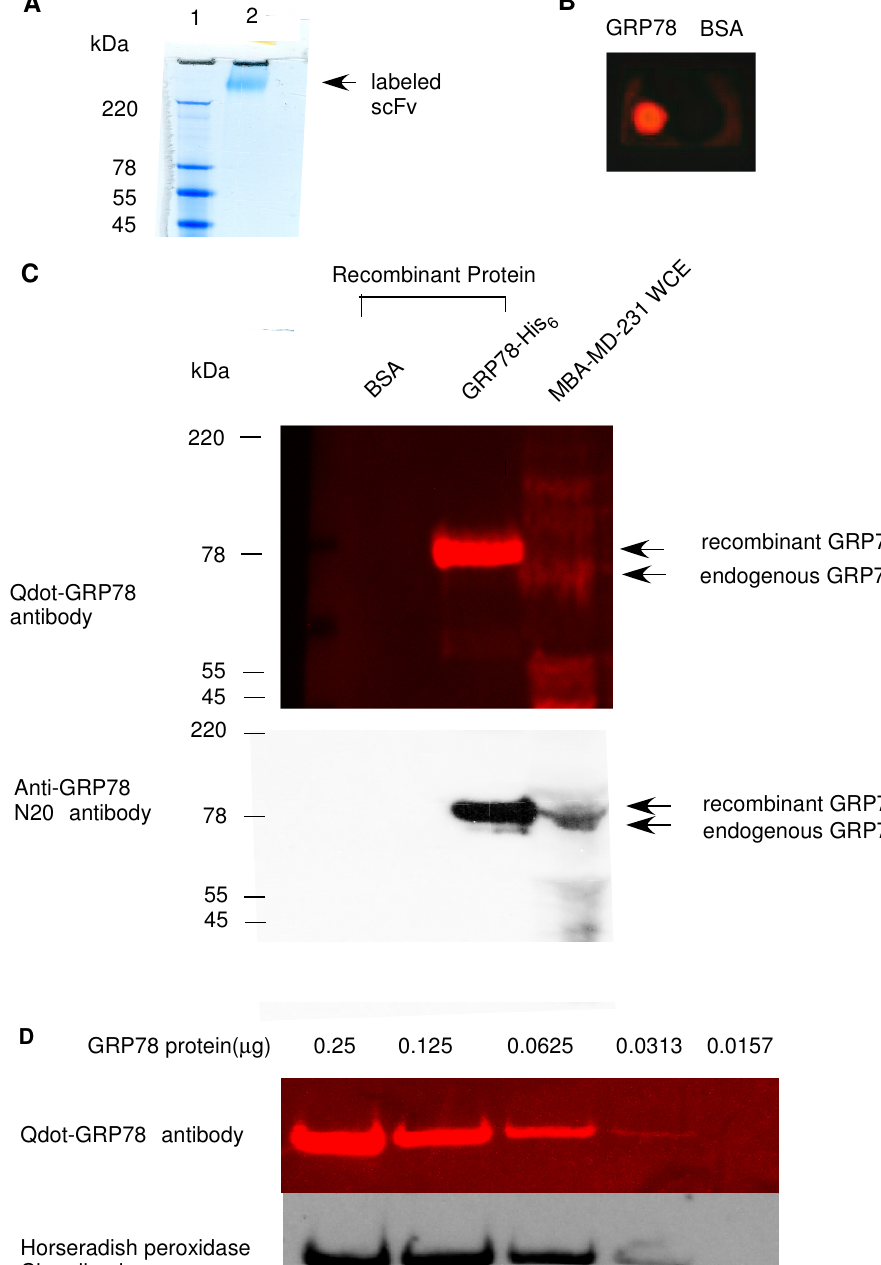
Figure 1. scFv-Grp78-H19 antibody was conjugated to a Qdot-625. ( A ) Coomassie blue-stained SDS-PAGE gel showing the Qdot labeled scFv; ( B ) Dot blot analysis of GRP78 protein binding by the Qdot625 labeled scFv; ( C ) Western blot analysis of GRP78 protein binding with Qdot625-GRP78 antibody with recombinant protein or whole cell extract (WCE) (upper panel). The same blot was hybridized with a goat-anti-GRP78 polyclonal antibody [N20, detected by horseradish peroxidase chemiluminescence (lower panel)]; ( D ) GRP78 protein was diluted in electrophoresis buffer and serial dilutions were then prepared and the western blot was probed with either anti-GRP78-Qdot625 scFv antibody (detected by UV illumination) or anti-GRP78-C20 polyclonal antibody (detected by horseradish peroxidase